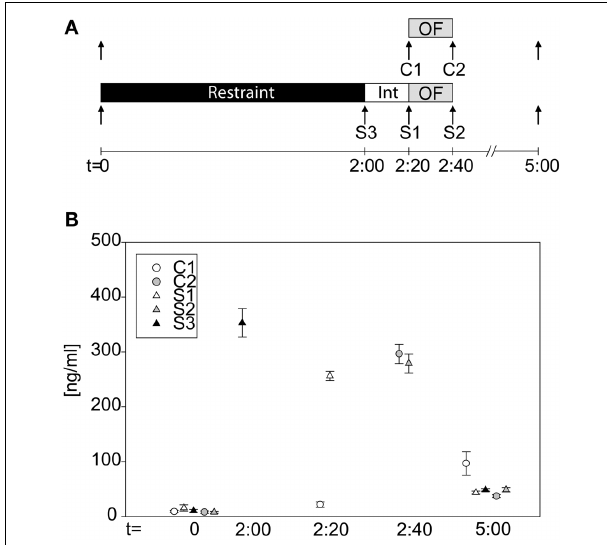
FIGURE 4 | Corticosterone profile during the acute stress test. (A) Scheme of the experimental design. Arrows indicate time point of blood withdrawal. C1 and C2 are control groups. Stressed groups, S1–S3, were exposed to a 2h restraint stress period (black bar) and a 20min interval (white bar) before they were placed into the OF. (B) CORT levels at the different time points of the different groups. At basal ( t = 0 h) no differences in CORT levels can be seen. Directly after stress (S3), after the interval (S1) and after the OF (S2) CORT levels of the stressed animals are high. CORT levels of the control group, C1, are low at t = 2 . 20h, whereas they are increased after the OF (C2). At t = 5h all groups have low circulating CORT levels again. Int, interval; n = 11–12 per group.